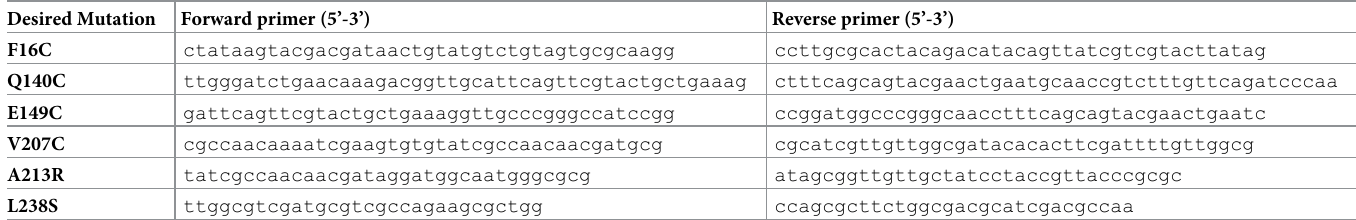
Table 1. Site directed mutagenesis primers. Desired Mutation Forward primer (5’-3’)